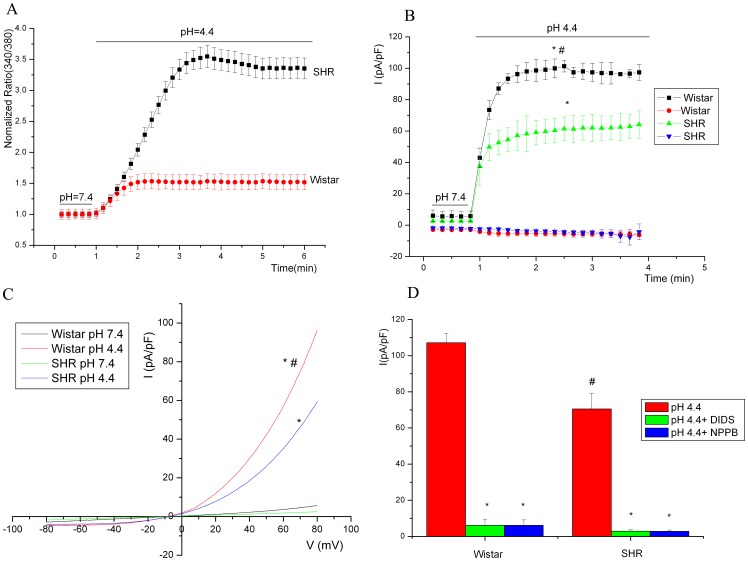
Severe acidosis increased intracellular calcium concentration and outward rectifying chloride channel currents in aorta smooth muscle cells (SMCs) from SHRs and Wistar rats.A, pH 4.4 solution increased intracellular calcium concentration in SMCs from SHRs as compared with Wistar rats. B, Mean current recordings at +80 and –80 mV membrane potentials obtained from voltage ramps during incubation with acidic solutions. C, Corresponding current–voltage relationships at the last sweep of voltage ramps showing the outward current with a clear outward rectification. D, The chloride channel blockers DIDS (100 µM) and NPPB (100 µM) abolished the outward current activated at pH 4.4. *P<0.01, compared with the control in both SHRs and Wistar rats. #
P<0.01, compared with SHRs.